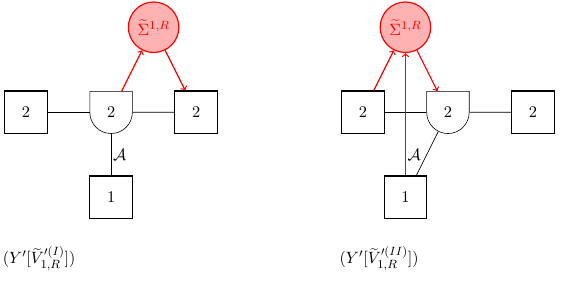
Figure 46 . Two different realizations of the vortex defect dual to the Wilson defect in the flavored D 4 quiver. The Witten index for the SQM in the first case should be computed in the chamber ξ < 0 , while for the second case it should be computed in ξ > 0